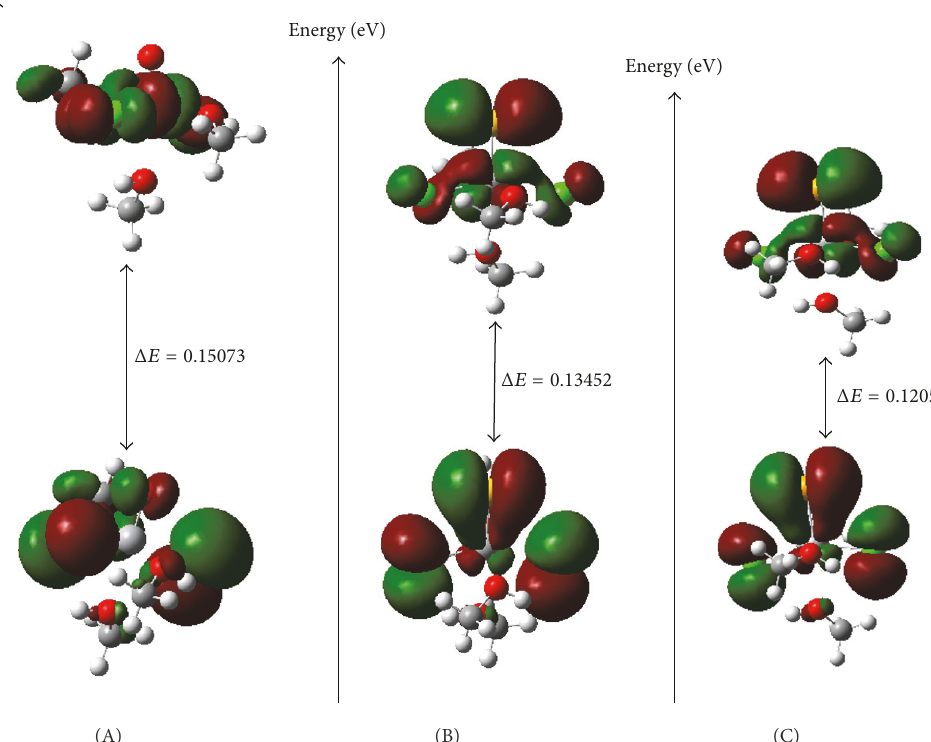
Figure 3: Frontier orbital energies of the respective complexes. A: VOCl 2 (OMe)(HOMe) 2 , B: VSCl 2 (OMe)(HOMe) 2 , and C: VSeCl 2 (OMe)(HOMe) 2